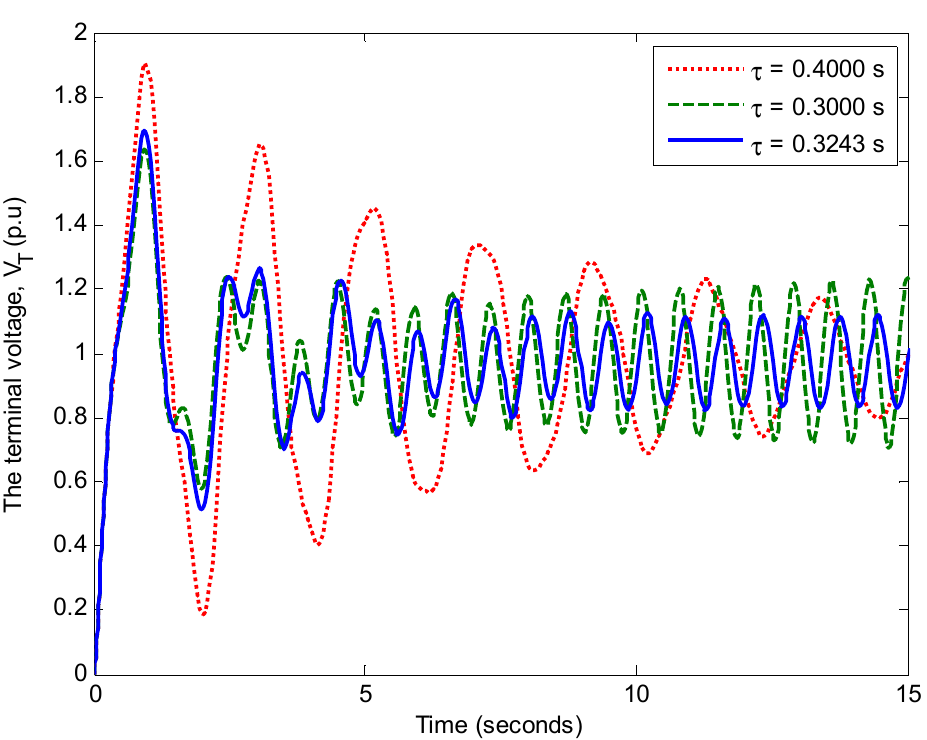
Figure 9. The terminal voltage with different time delays.